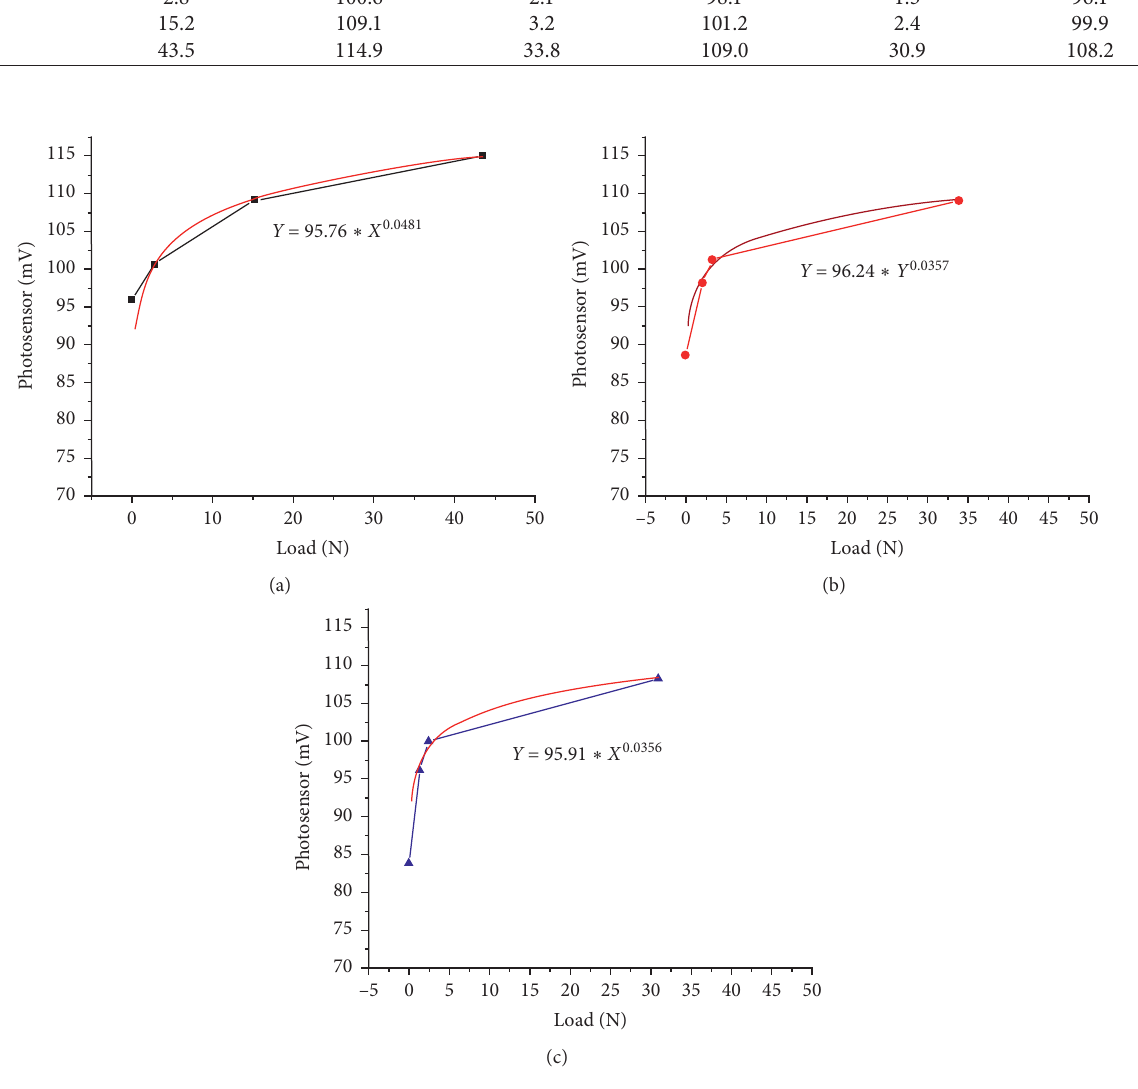
Figure 7: Load graphics vs. response of the photosensor with exponential adjustment for the tests T1 (a) (standard error � 0.1215), T2 (b) (standard error � 1.0912), and T3 (c) (standard error � 0.9940).